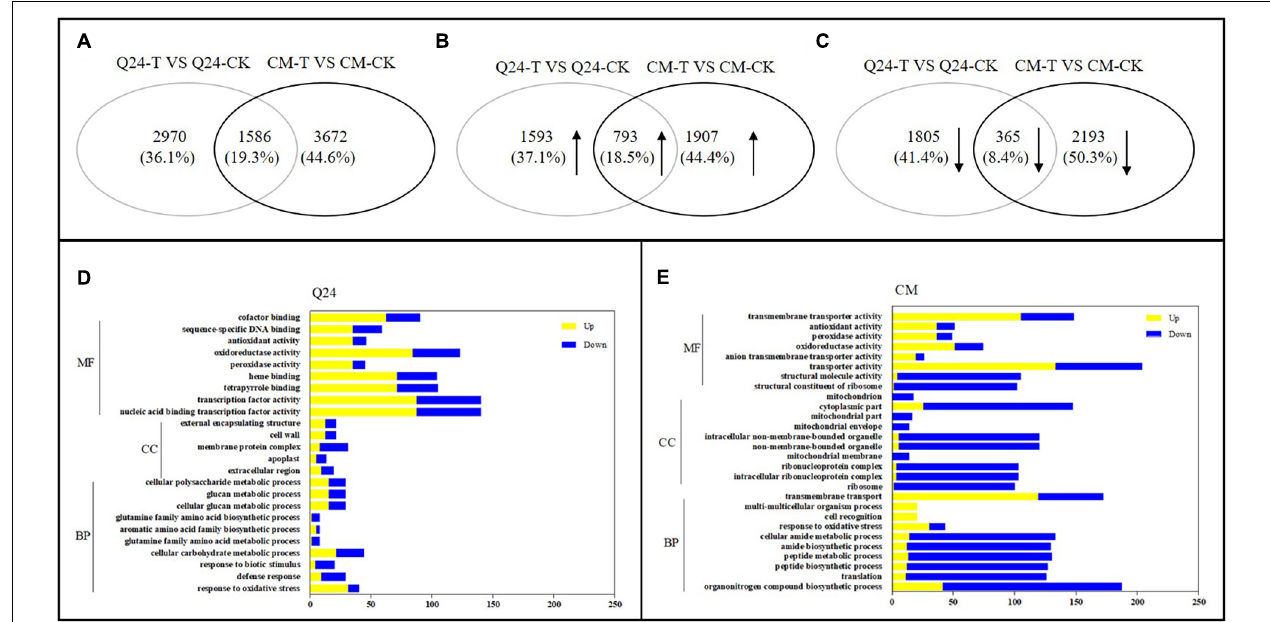
FIGURE 2 | The number of differentially expressed genes (DEGs) and Gene Ontology (GO) enrichment analysis in responding to the infection of M. incognita in Q24, CM. (A) All DEGs mapped in Q24 and CM (adjusted P < 0.05); (B) the upregulated DEGs mapped in Q24 and CM (adjusted P < 0.05); (C) the downregulated DEGs mapped in Q24 and CM (adjusted P < 0.05). The percentage in (A–C) was the number of DEGs related to the total of identified DEGs in all DEGs, in all upregulated DEGs or in all downregulated DEGs in Q24, CM; (D) GO terms of DEGs in Q24; (E) GO terms of DEGs in CM. Yellow indicated upregulation and blue indicated downregulation. DEGs were classified into specific biological process categories with high classification stringency (adjusted P < 0.05). The horizontal ordinate represents the number of genes in the category. MF, molecular function; CC, cellular component; BP, biological process.